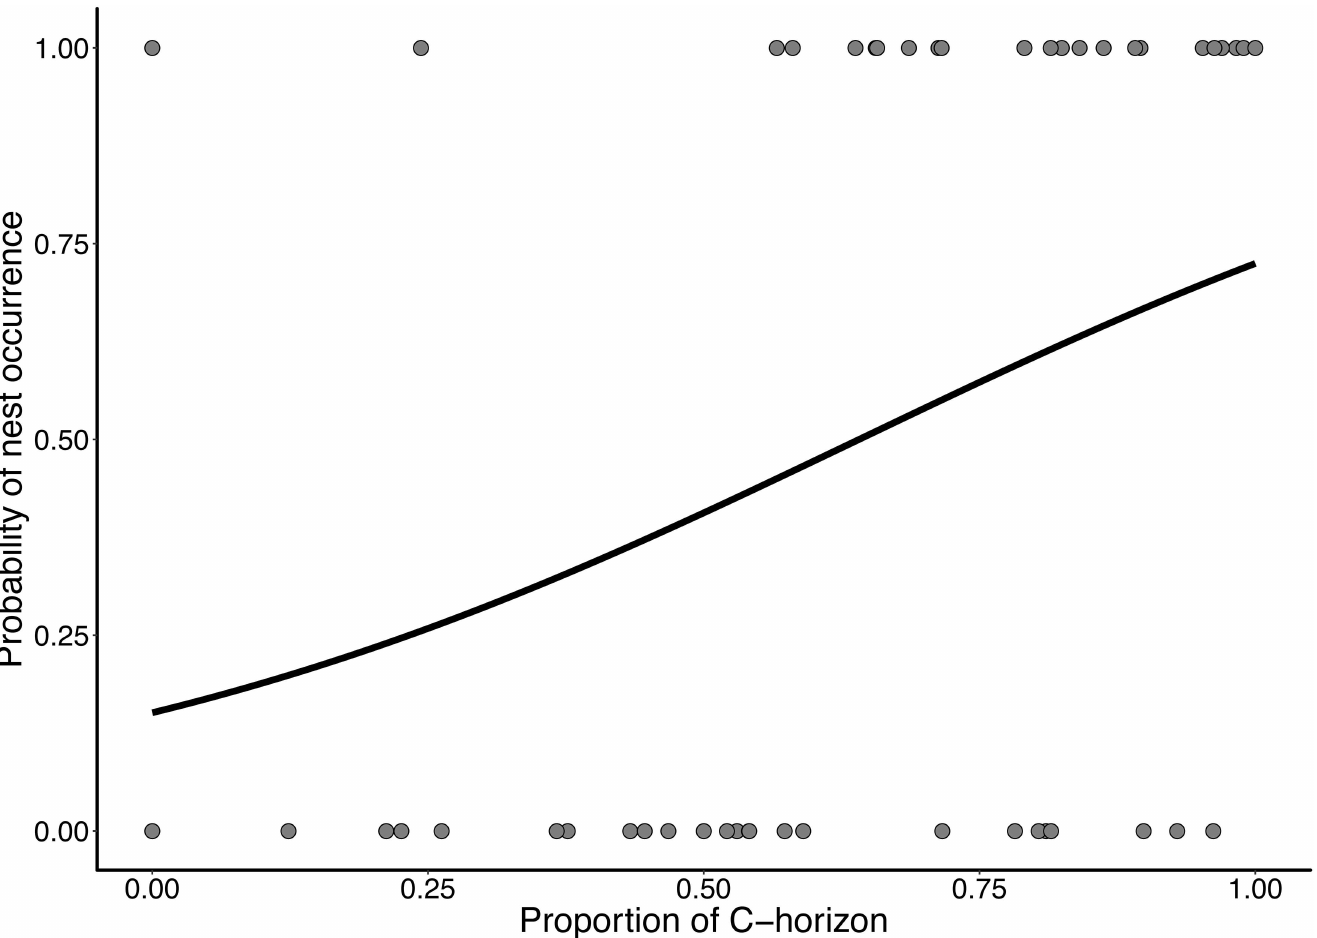
Fig 6. Probability of nest occurrence of Geosittapoeciloptera according to the proportion of the C-horizon in the Upper Rio Grande Grasslands, southeastern Brazil. 0: steep soil banks without nests; 1: steep soil banks with nests ( χ 2 = 6.11, Df = 48, P = 0.013).